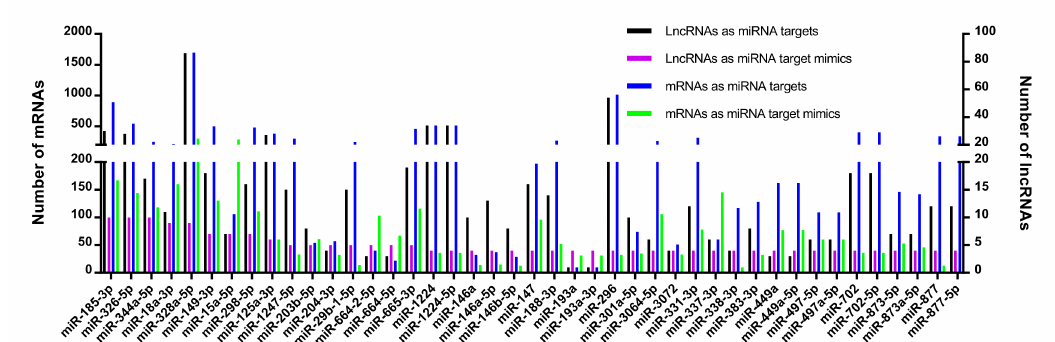
Figure 6. The number of alignments formed by miRNA-DE-lncRNA and miRNA-mRNA duplexes. The X -axis legend shows the miRNAs. The Y -axis legend represents the number of lncRNAs ( right ) or mRNAs ( left ) that function as miRNA target or target mimics. The different colors of bars indicate different types of RNAs.